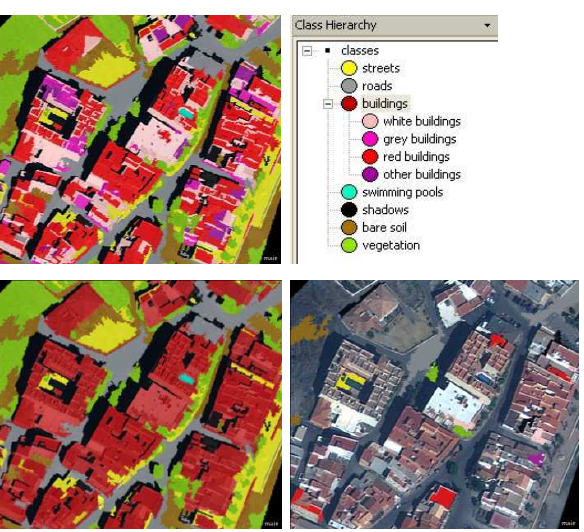
Figure 4. Classification detail of one of the four repetitions using SAVI and nDSM, with 10 classes (left above) and with 7 classes (left bellow). Class hierarchy is showed on the top right and samples for training are down to the right.